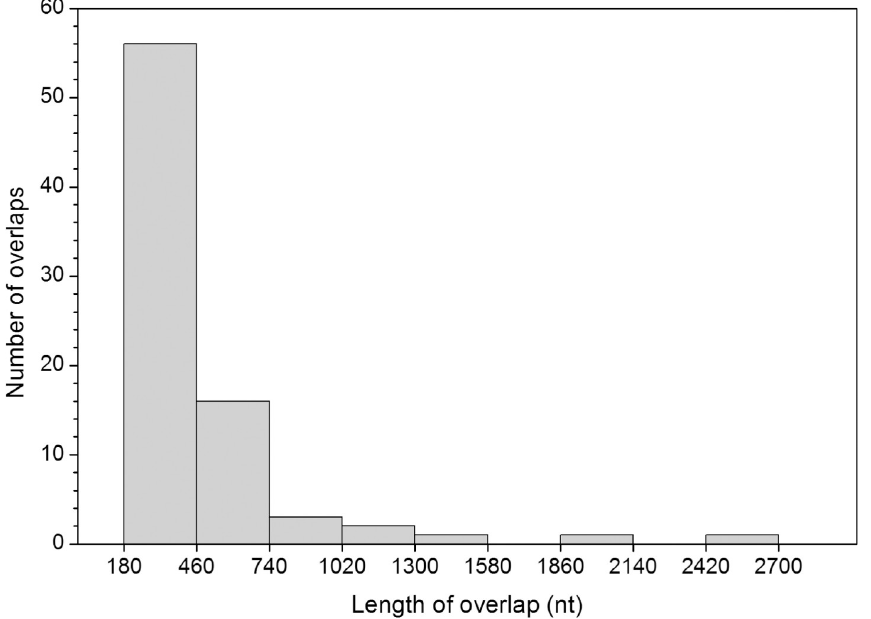
Fig 1. Frequency distribution of the length of the 80 overlapping genes of the